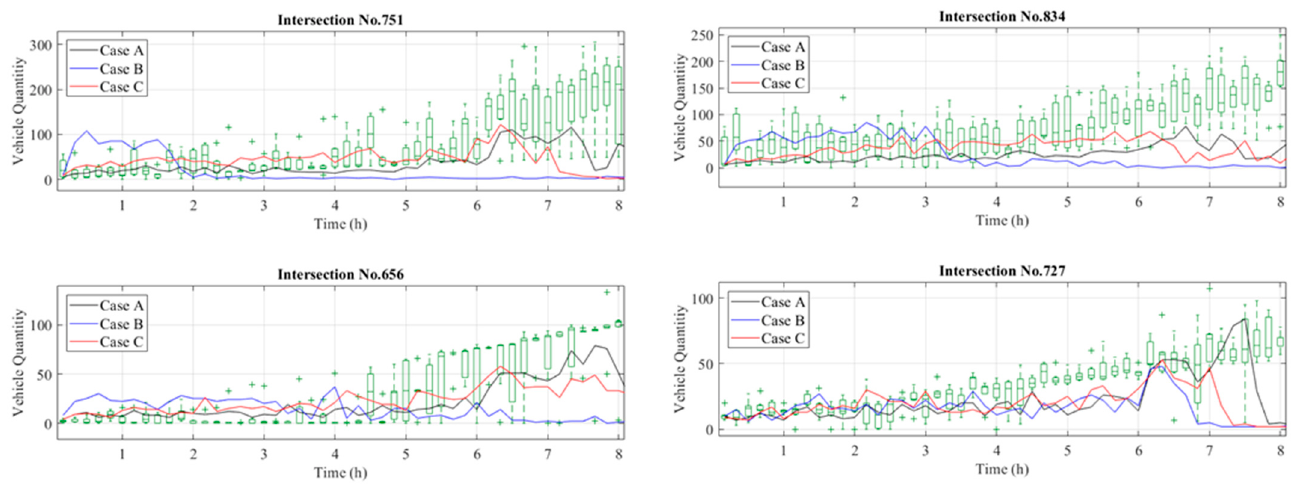
Figure 7. Comparison of simulation results and real data.